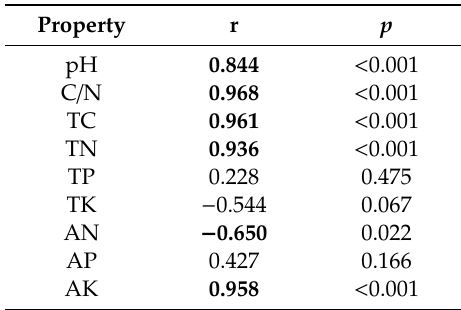
Table 2. The correlation (r) and significance ( p ) values of the pairwise regressions between biochar dosage and soil